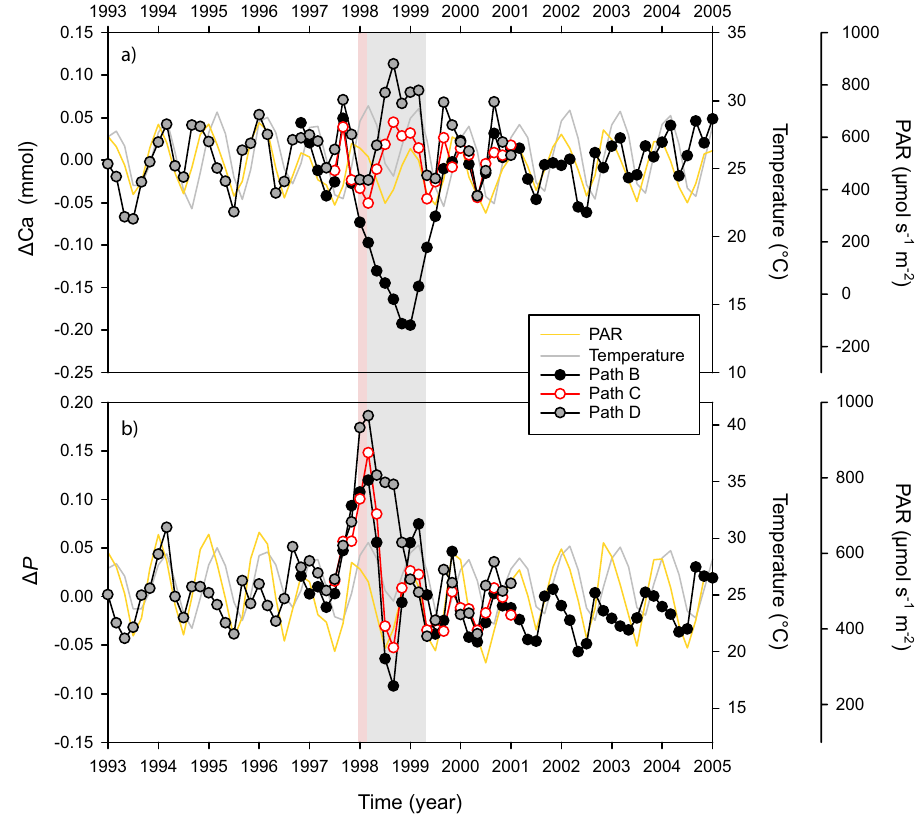
Figure 5. Bimonthly (interpolated) anomalies ( Δ ) for the modelled changes in: ( a ) the concentration of Ca 2 + in the calcifying fluid ([Ca 2 + ] cf ) and ( b ) the proportion of Ca 2 + remaining in a batch of calcifying fluid after calcification finalizes ( P ). Anomalies ( Δ Ca or Δ P ) were estimated by subtracting the expected seasonal variation due to temperature from the modelled data. The temperature expected values were based on the inverse relationships of P and [Ca 2 + ] cf with temperature (Supplementary Fig. S3). First the expected (predicted) P and [Ca 2 + ] cf from temperature changes alone were estimated using the corresponding equations in the supplementary Table S1. Then the resulting predicted values were subtracted from the P or [Ca 2 + ] cf values modelled from the trace elements Sr/Ca and Mg/Ca. The pink shaded area highlights the timing of the 1998 bleaching event, the grey shaded area highlights the recovery period. Seawater temperature and PAR (light) are shown for comparison